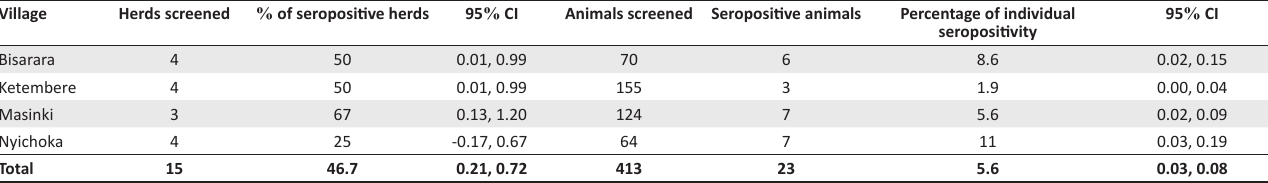
TABLE 1: Herd and individual level Brucella seropositivity in selected villages of Serengeti district. Village Herds screened % of seropositive herds 95 % CI Animals screened Seropositive animals Percentage of individual